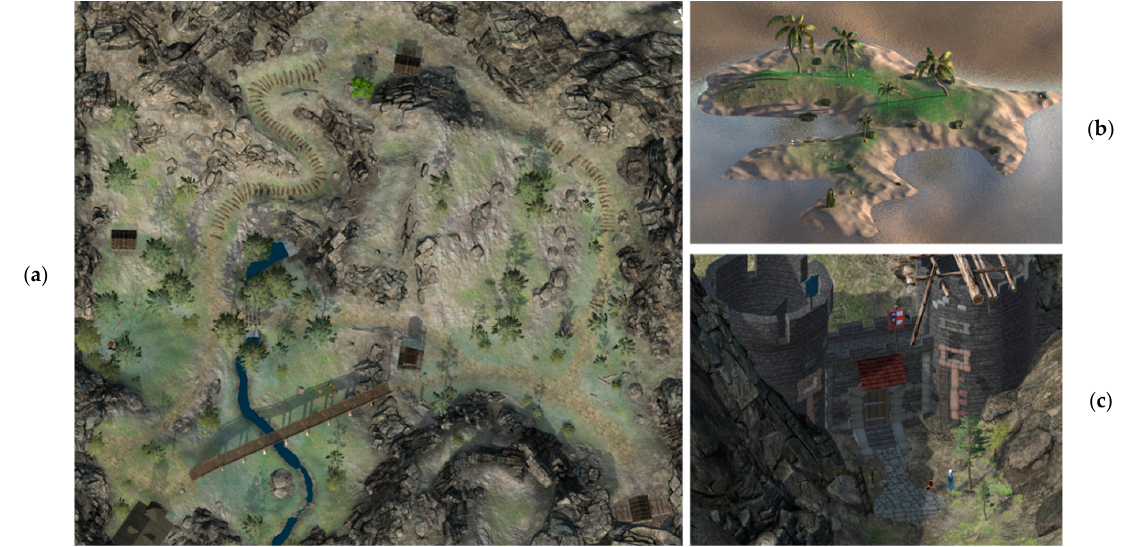
Figure 1. Isometric, elevated overview of map A ( a ), map B ( b ), and map C ( c ) .